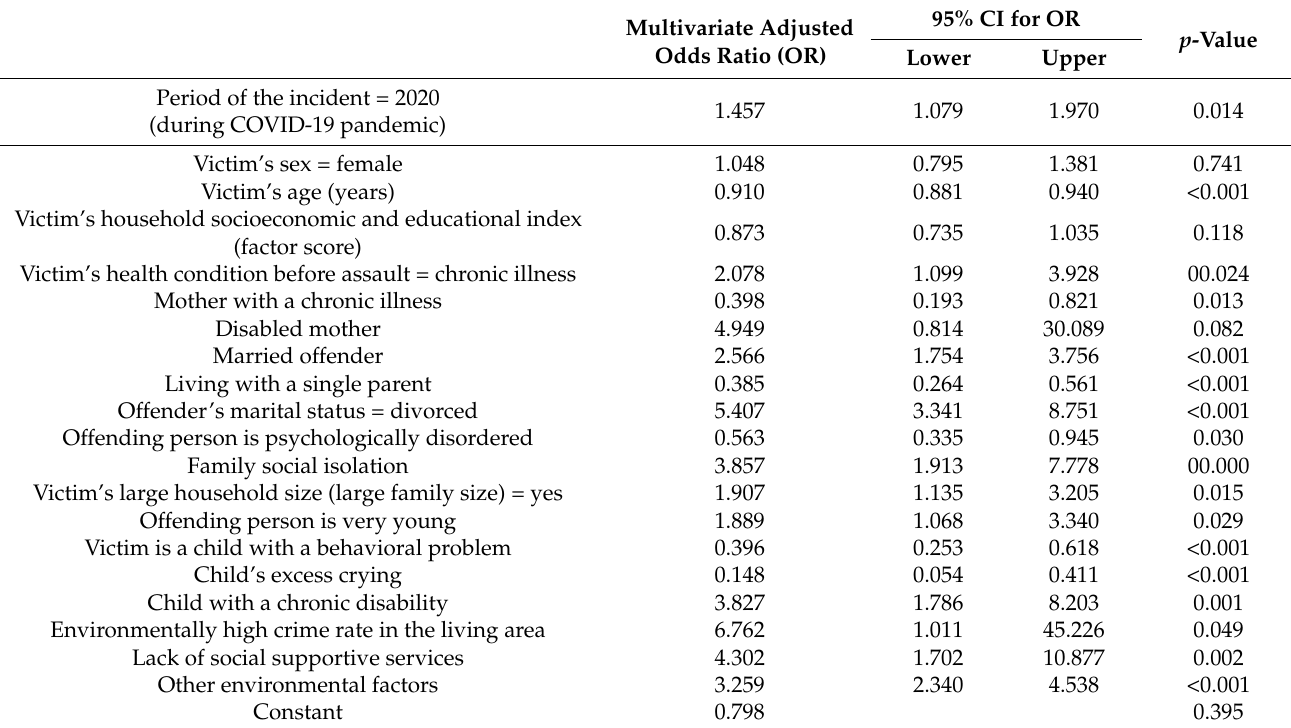
Table 7. Multivariate logistic binary regression analysis of children’s odds of neglect ( n = 1304). Multivariate